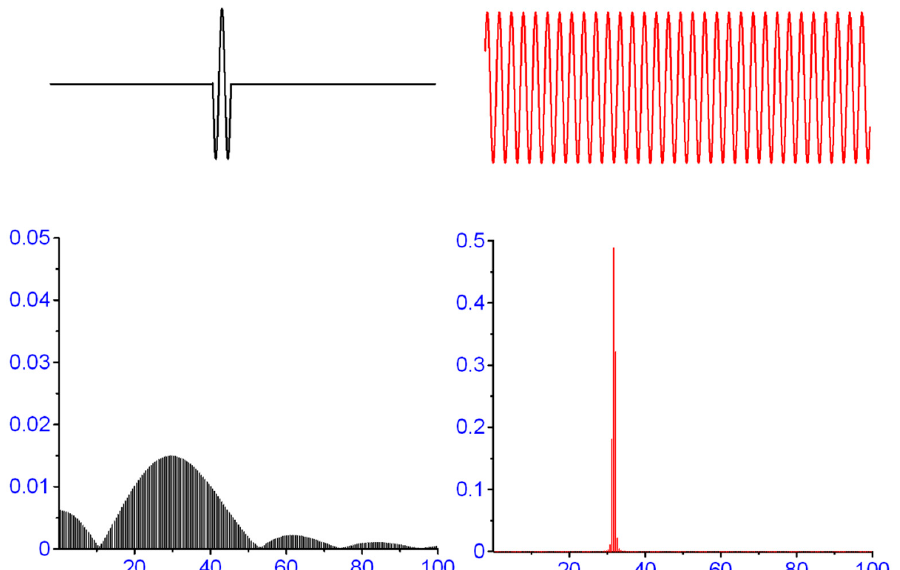
Figure 2. A simulated data set of an MEP (three half-cycled sine wave on the left) and a continuous sine wave (right) with the same periodicity. The different degrees of signal representation resulted in a different frequency spectra quality. The corresponding spectra are arranged below. Note: the amplitude scale (arbitrary units) on the right spectrum is 10 times higher, while the spectrum of the left shows important spreading of the original frequency (arbitrary units) into the adjoining frequency bins. The two signals in the time domain represented, on the one hand, a signal with a transient property (impulse) and on the other, a signal with a clearly periodic property.